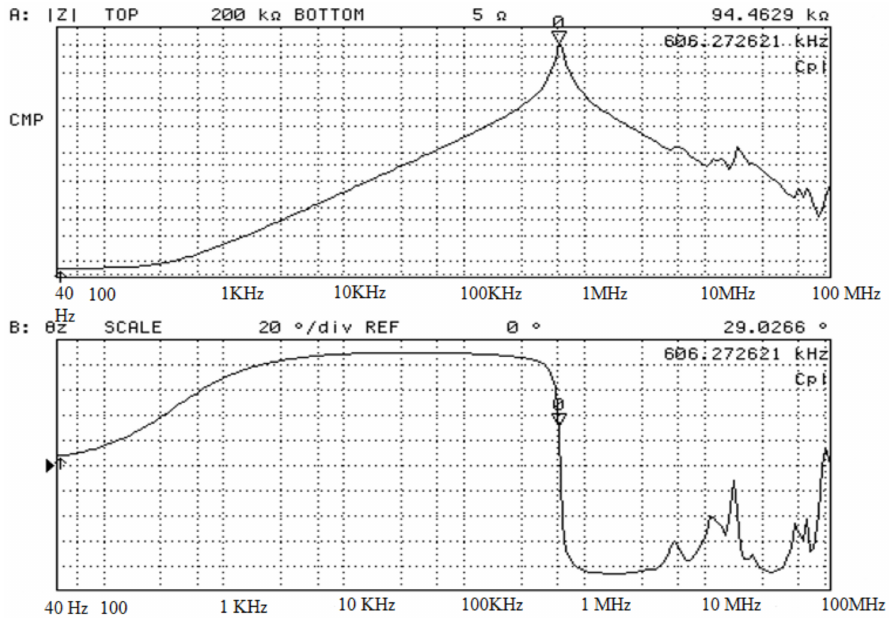
Figure 4. Frequency response of the used coil sensor obtained with an impedance analyzer